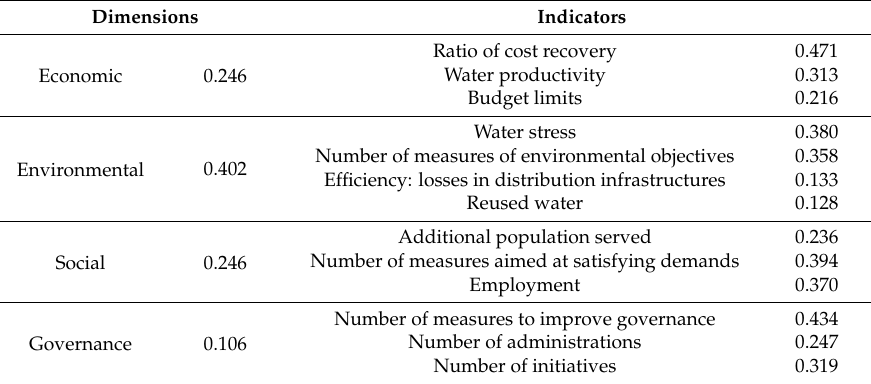
Table 4. Normalised weights for dimensions/criteria and